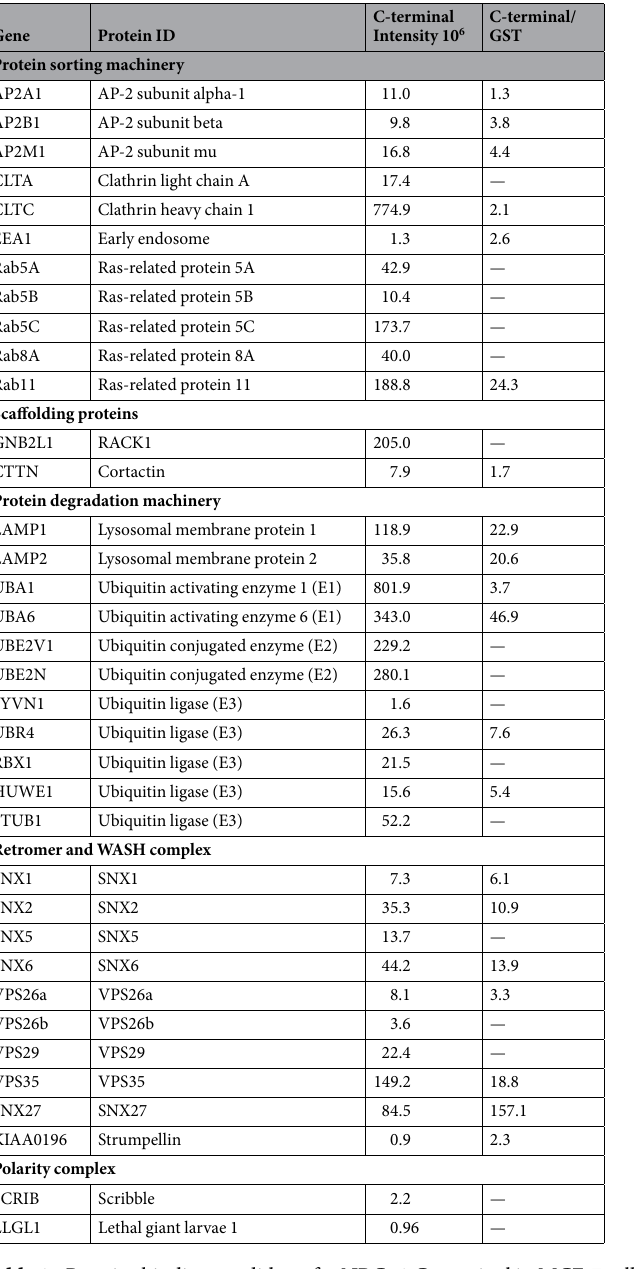
carried out GST-pull-down with the NBCn1 C-terminal in MCF-7 cell lysates, followed by mass spectrometry (MS) analysis to identify possible binding partners. This revealed multiple possible interaction partners with a robust detection ratio over GST alone (Table 1). Several groups of proteins relevant for protein sorting, trafficking and degradation were identified (Table 1). Firstly, we found a large group of mediators involved in clathrin-dependent endocytosis, such as clathrin light and heavy chains, the adaptor protein (AP)2 complex subunits α -1, ß, and µ , and also endosomal Rab proteins such as Rab5A, -B, and -C as well as Rab11 and Rab8. A second group of identified proteins of interest were cortactin, which is important for membrane targeting of other plasma membrane proteins 30 , and the small scaffolding